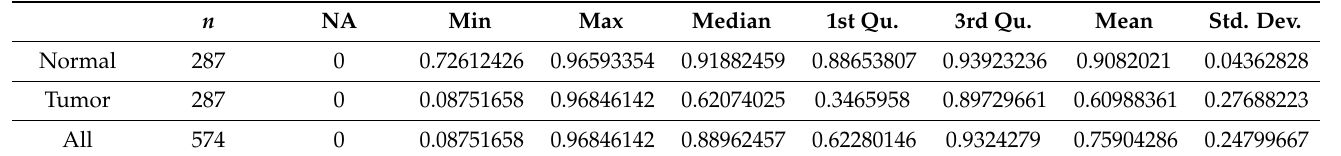
Table 5. Liver β -values and statistics.